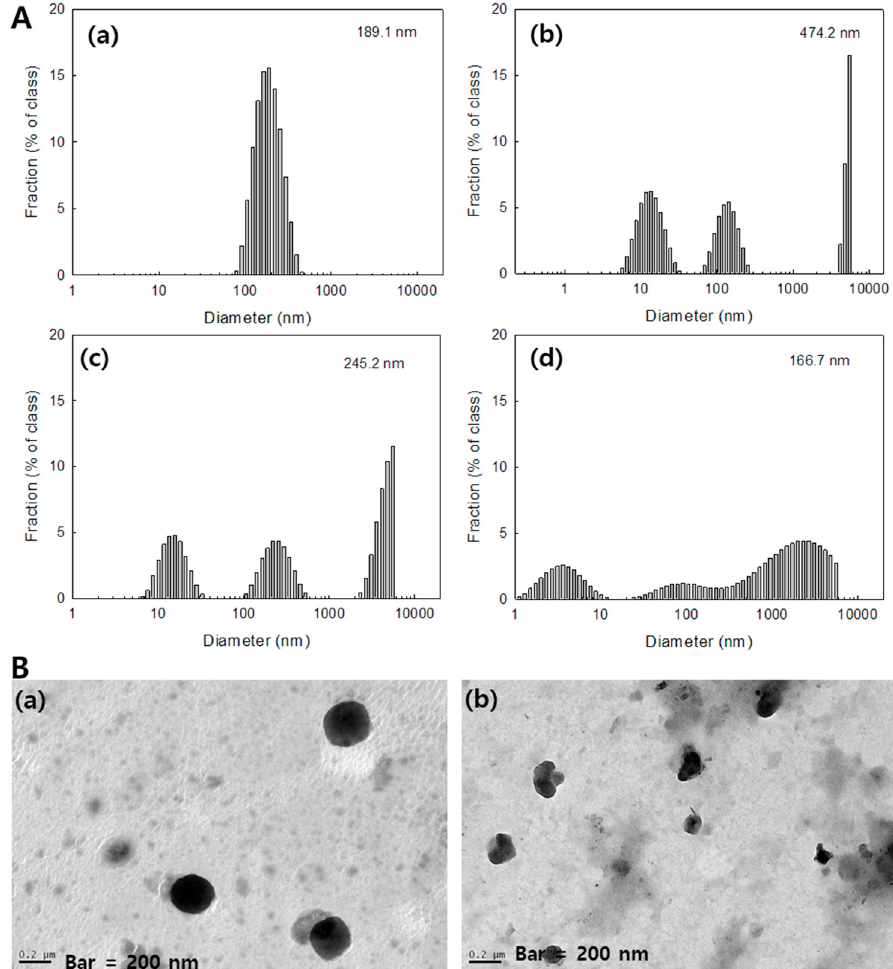
Figure 2. (A ) Particle-size distribution of FA–PEG 3500 -ss-Ce6tri copolymer nanophotosensitizers. GSH concentration: ( a ) L-glutathione reduced (GSH), 0 mM; ( b ) GSH, 5 mM; ( c ) GSH, 10 mM; ( d ) GSH, 20 mM; ( B ) morphologic observations of FA–PEG 3500 -ss-Ce6tri copolymer nanophotosensitizers. ( a ) GSH, 0 mM; ( b ) GSH, 10 mM.